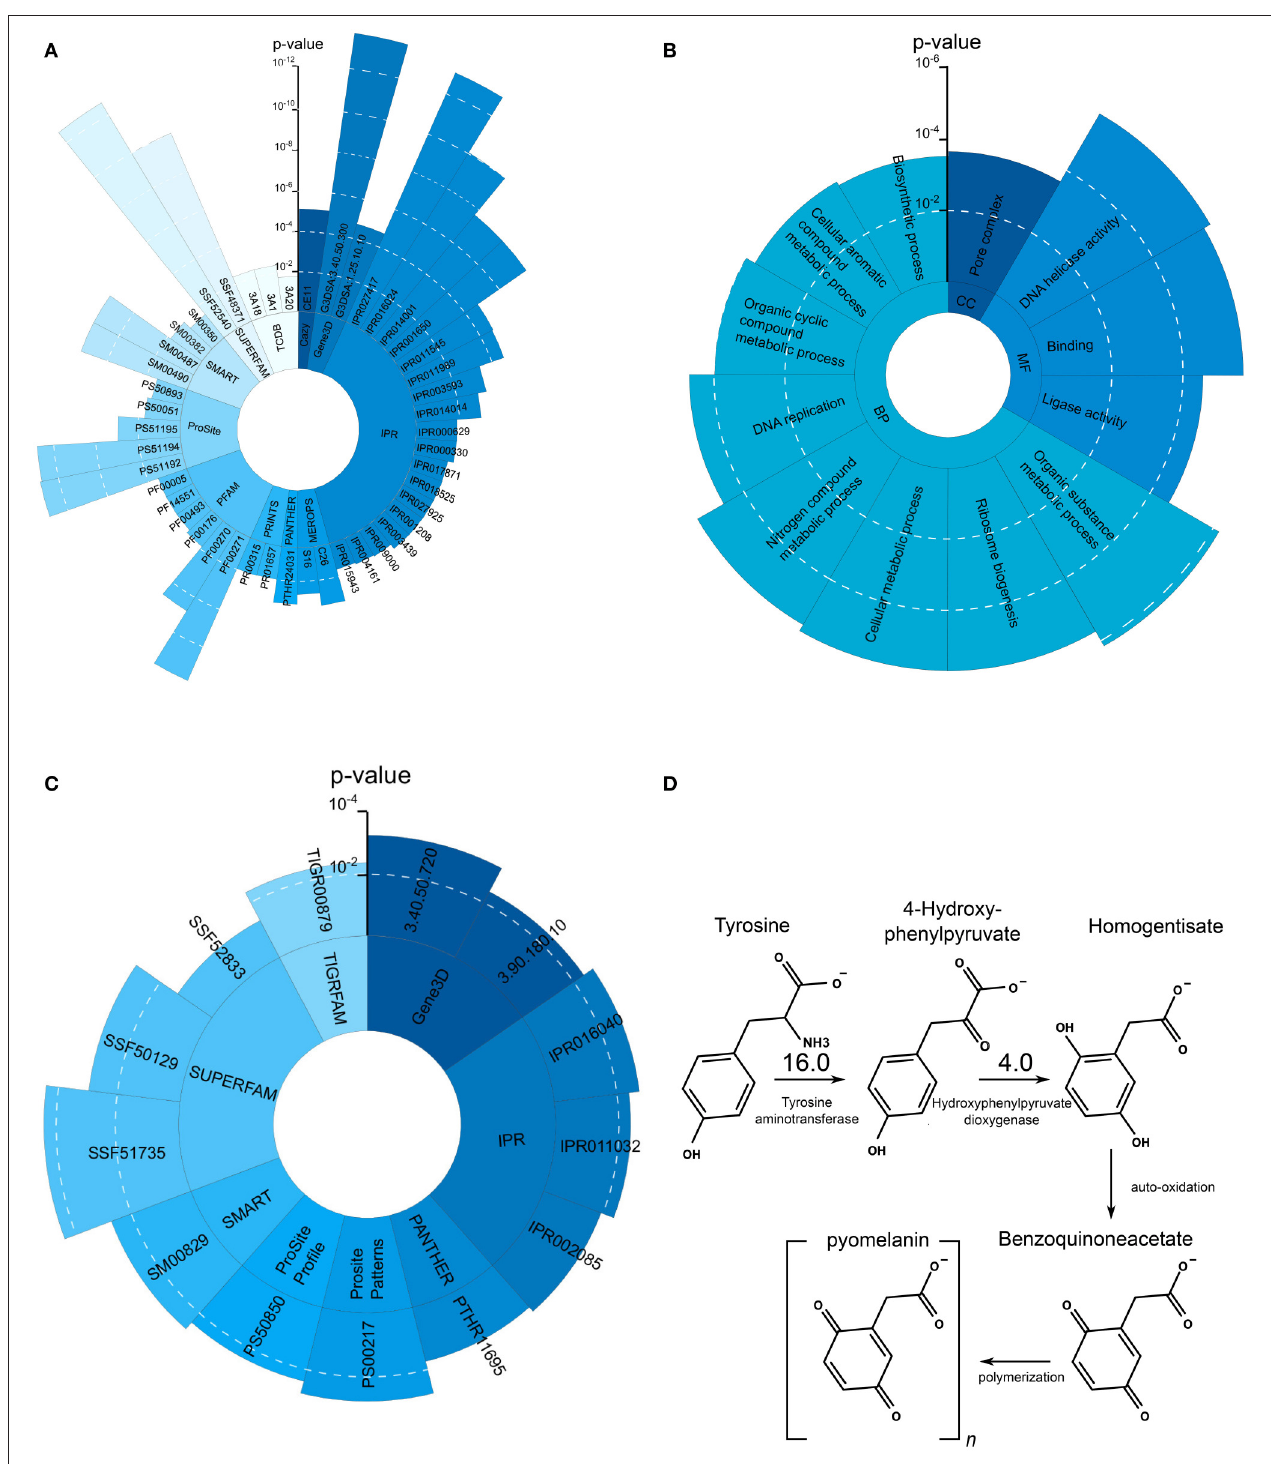
FIGURE 4 | Significantly overrepresented protein domains and GO terms as well as L-Tyrosine melanin metabolism. (A) Overrepresented protein domains in the set of upregulated genes during growth on skin. Each blue shade represent another enriched domain category. (B) Overrepresented GO terms in the set of upregulated genes during growth on skin. (C) Overrepresented GO terms in the set of downregulated genes during growth on skin. (D) L-Tyrosine degradation pathway leading to the production of pyomelanin. Compared to the control condition Tat and HppD are upregulated 16 and 4 times, respectively.